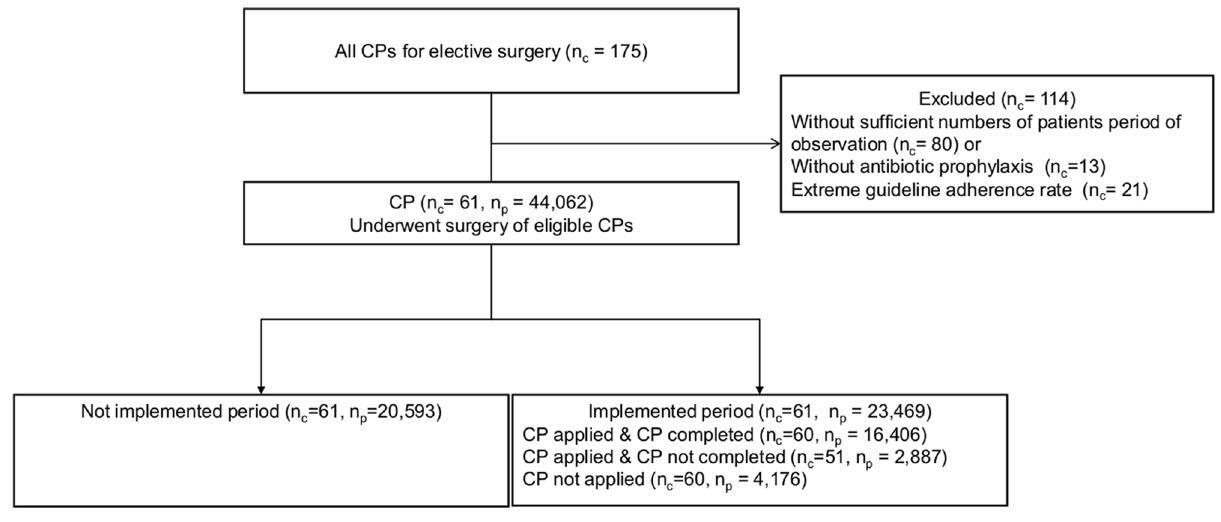
Figure 1. Flowchart showing the research